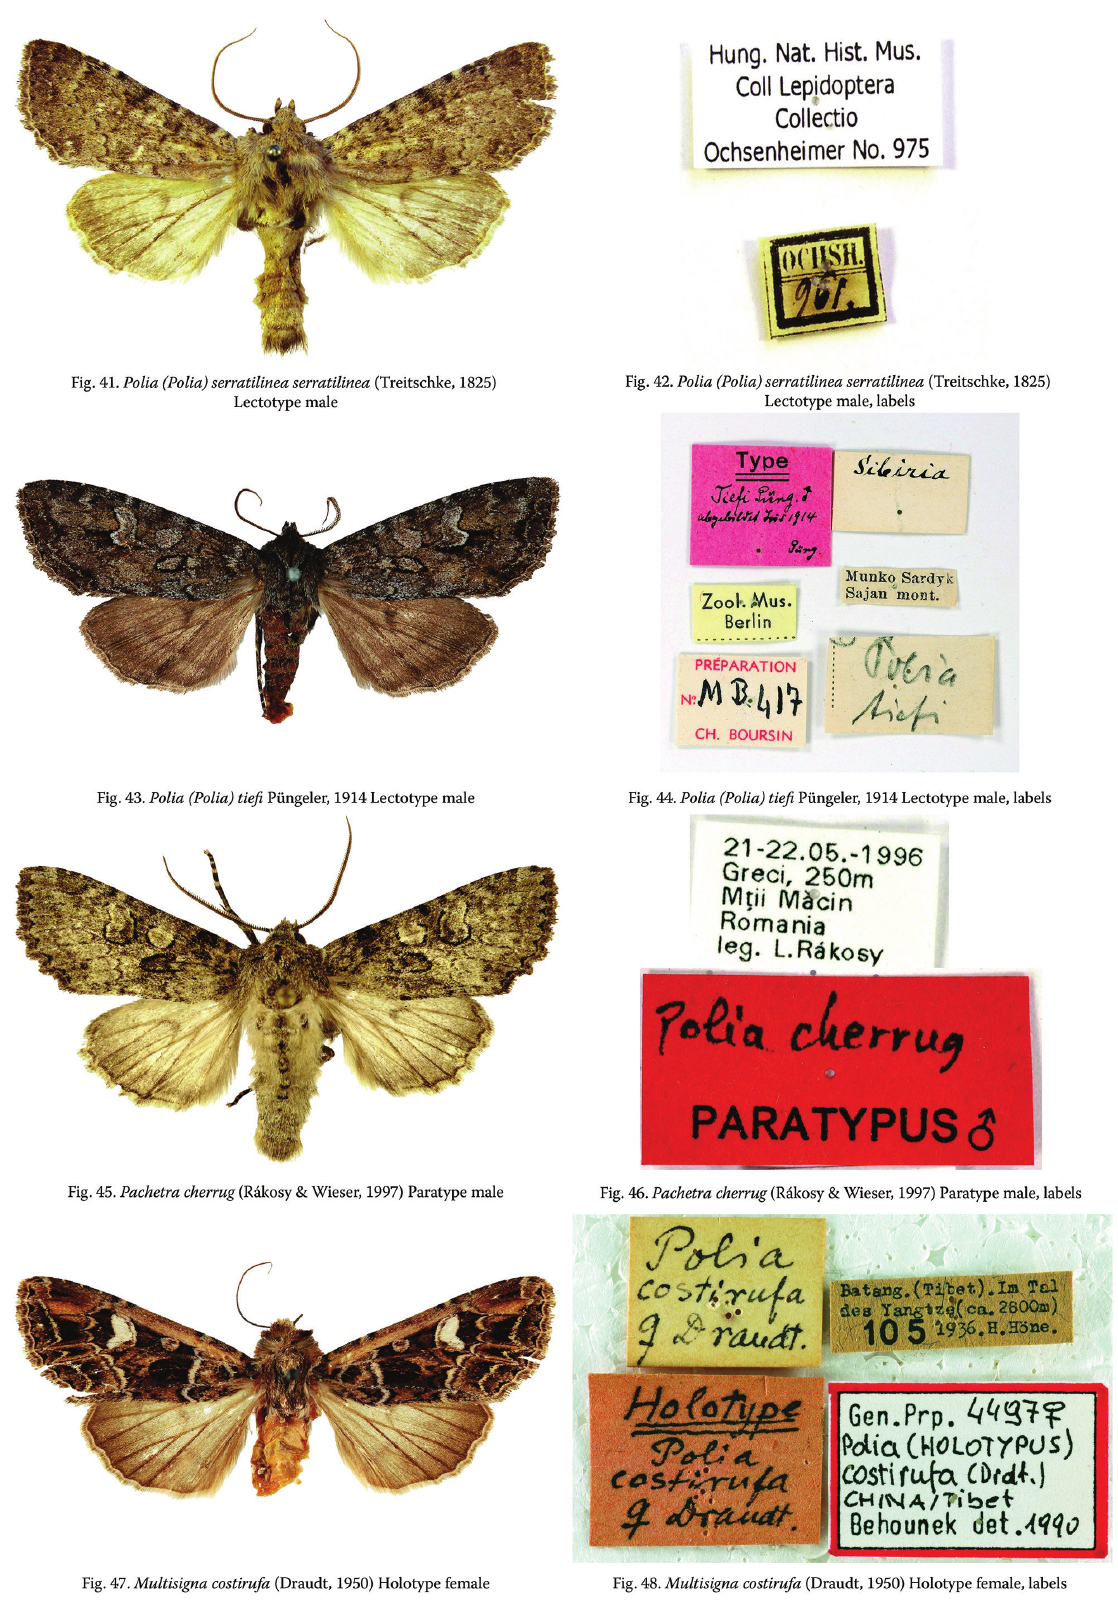
Figure 41–48. 41. Polia ( Polia ) serratilinea serratilinea (Treitschke, 1825) Lectotype male. 42. Polia ( Polia ) serratilinea serratil- inea (Treitschke, 1825) Lectotype male, labels. 43. Polia ( Polia ) tiefi Püngeler, 1914 Lectotype male. 44. Polia ( Polia ) tiefi Pünge- ler, 1914 Lectotype male, labels. 45. Pachetra cherrug (Rákosy & Wieser, 1997) Paratype male. 46. Pachetra cherrug (Rákosy & Wieser, 1997) Paratype male, labels. 47. Multisigna costirufa (Draudt, 1950) Holotype female. 48. Multisigna costirufa (Draudt, 1950) Holotype female,